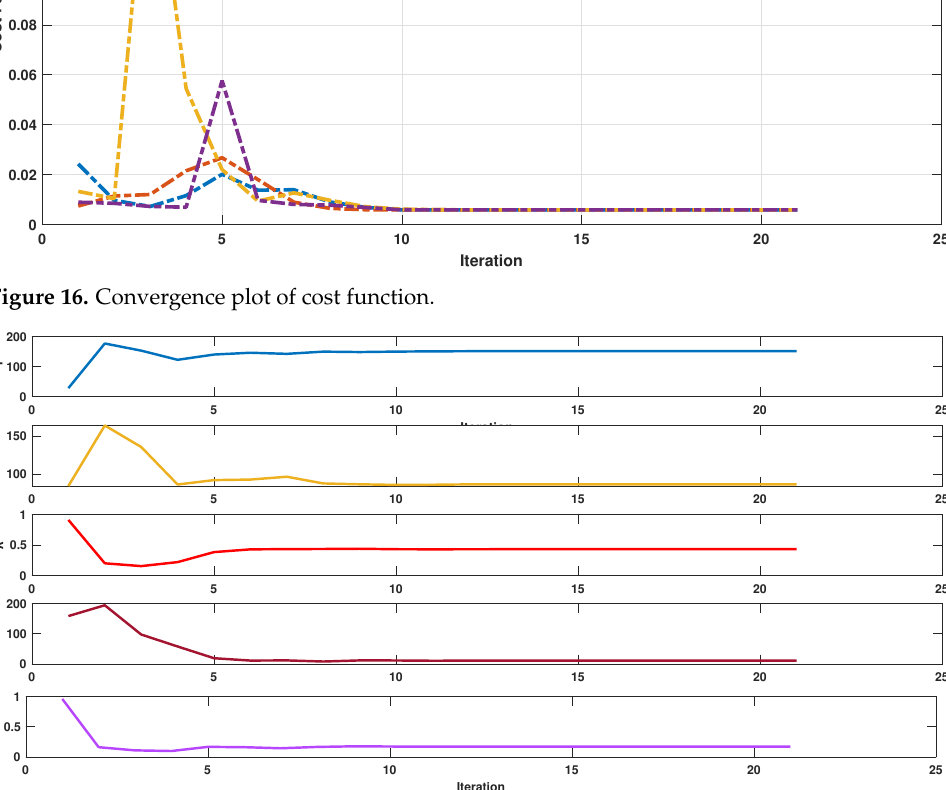
Figure 17. Convergence plot of the FOPID parameters.